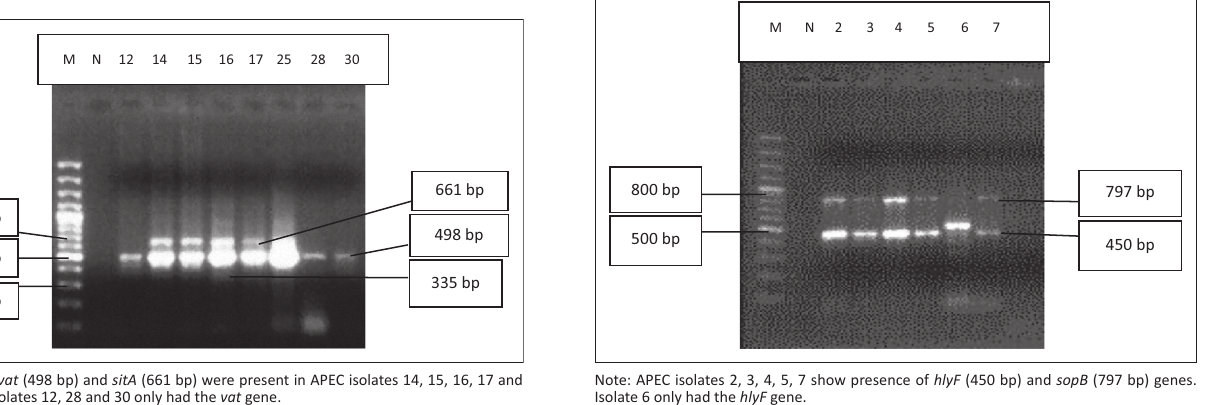
FIGURE 2: Multiplex 2. Lane M indicates the lane containing the marker, GeneRuler 100 bp Plus DNA Ladder (Thermo Scientific, Waltham, Massachusetts, USA) whilst lane N indicates the negative control.